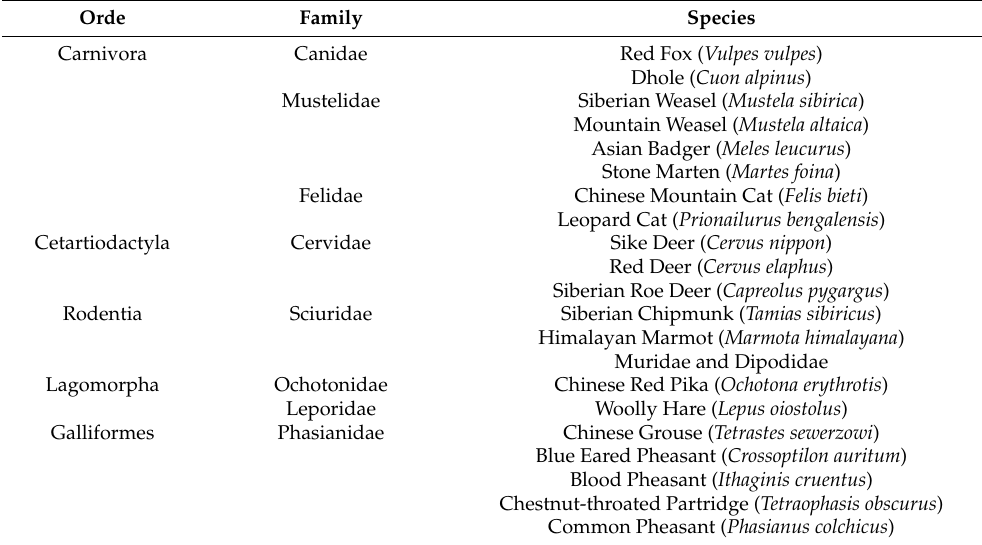
Table 2. Terrestrial birds and mammals detected in